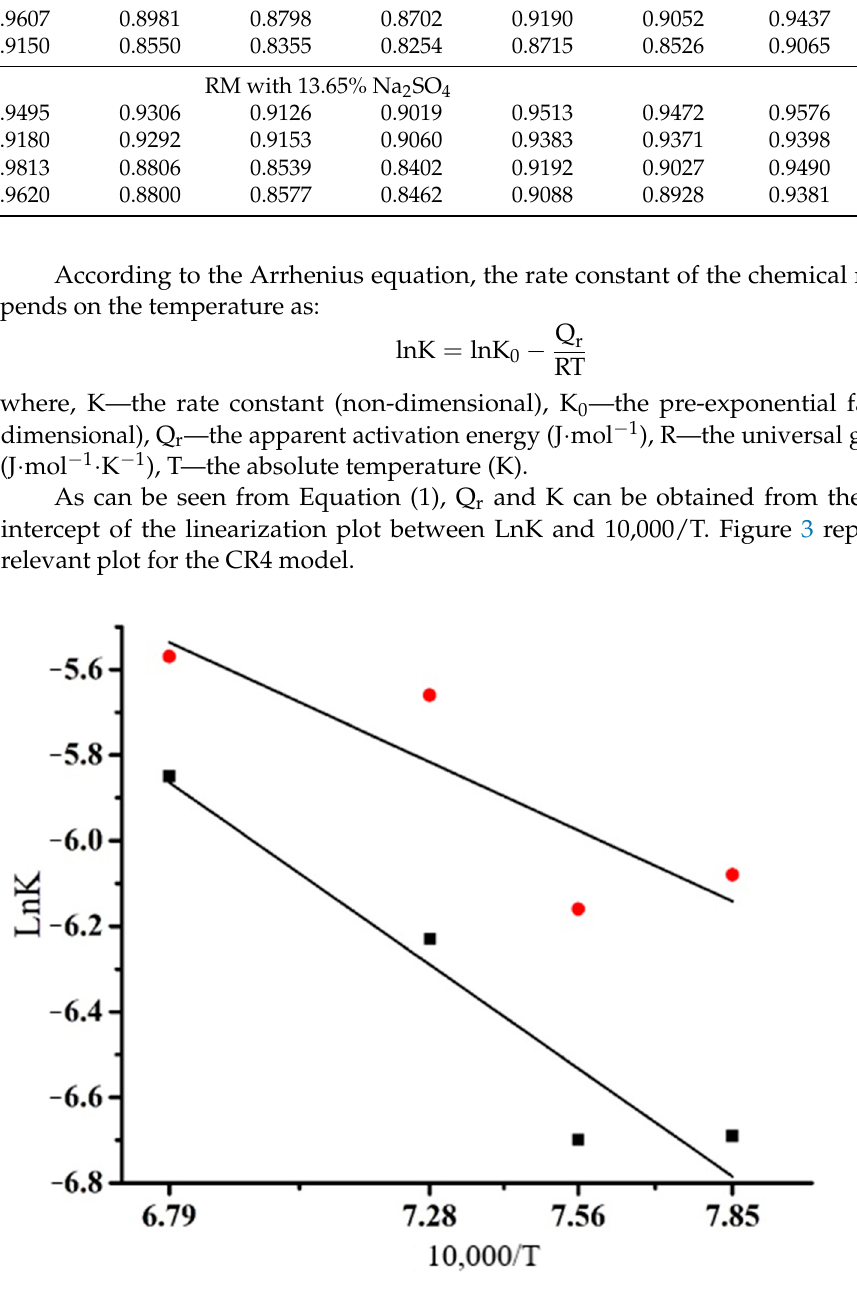
Table 4. Kinetic parameters of the reduction process.